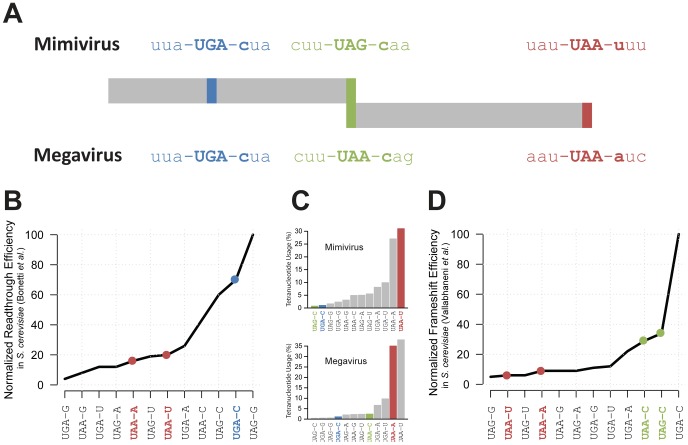
Representation of Mimivirus R726 and Megavirus mg280 coding regions.A) Representation of Mimivirus R726 and Megavirus mg280 coding regions. The sequences of the three stop codons and their neighboring codons are shown. The readthrough stop is in blue, the frameshift stop in green and the last stop in red. B) The readthrough efficiency in S. cerevisiae of all possible stop codons tetranucleotides is reported from [32]. The values were normalized as a percentage of the most efficient tetranucleotide. C) Histogram of the percentage of stop codons tetranucleotides used in Mimivirus (top) and Megavirus (bottom). The three stops colors correspond to A. D) The frameshift efficiency in S. cerevisiae of all possible stop codons tetranucleotides is reported from [36]. The values were normalized as a percentage of the most efficient tetranucleotide.